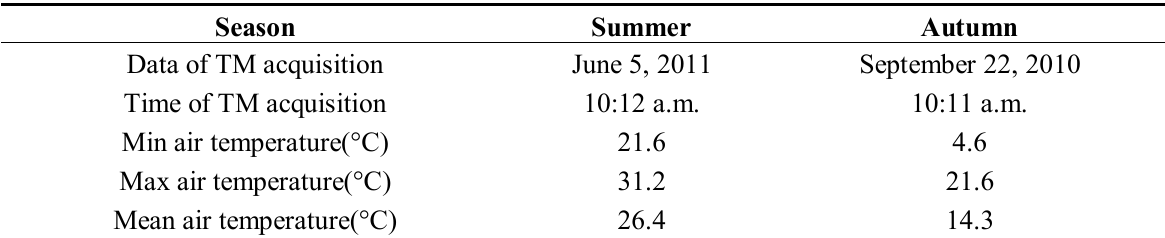
Table 1. Meteorological records on the dates of the Landsat-5 Thematic Mapper (TM) imagery acquisition in Changchun.